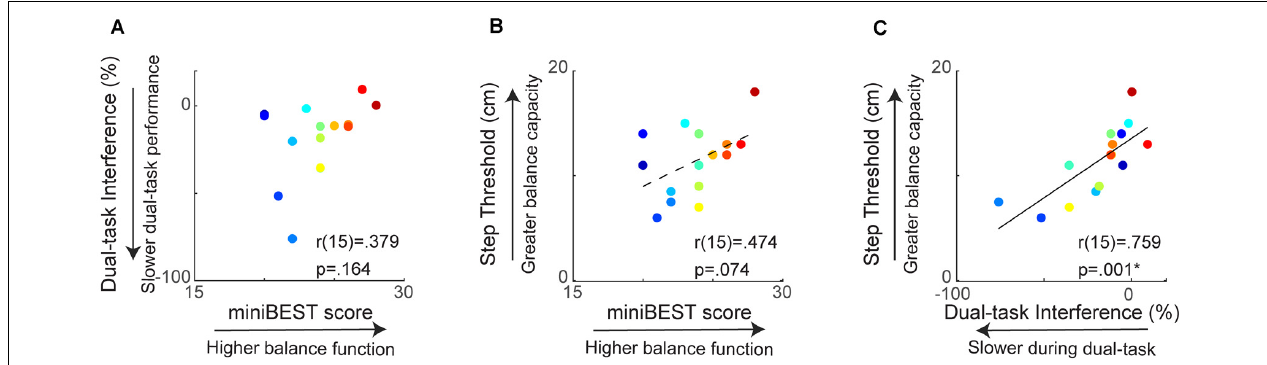
FIGURE 2 | Relationship between clinical behavioral balance function and reactive step threshold. MiniBEST score was not significantly associated with cognitive dual-task interference (DTI) (A) or reactive step threshold (B) . Cognitive DTI was positively correlated with reactive step threshold, where older adults with more slowing during dual-task performance had lower reactive step thresholds (* p = 0.001) (C) .